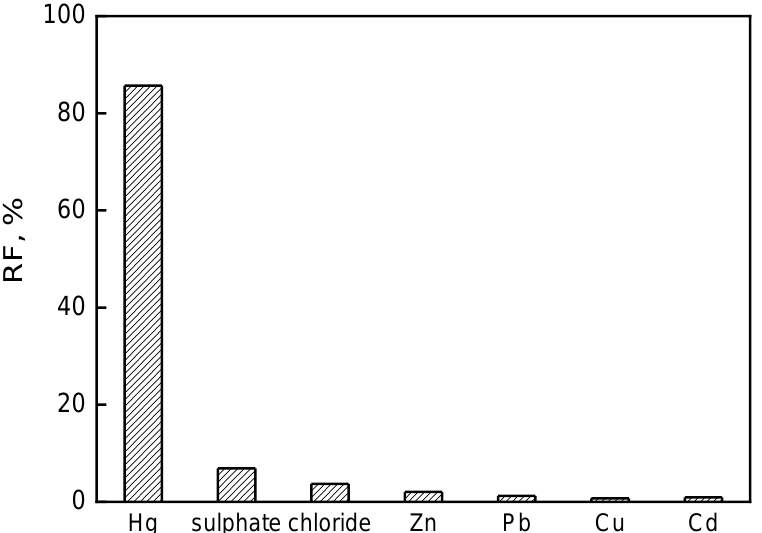
Figure 9. The RF values obtained in the competitive PIM transport of mercury from zinc smelting wastewater sample. Membrane: 19 wt.% of CTA, 4 wt.% of KP, 77 wt.% of o -NPOE; receiving phase: 0.1 M NaCl.